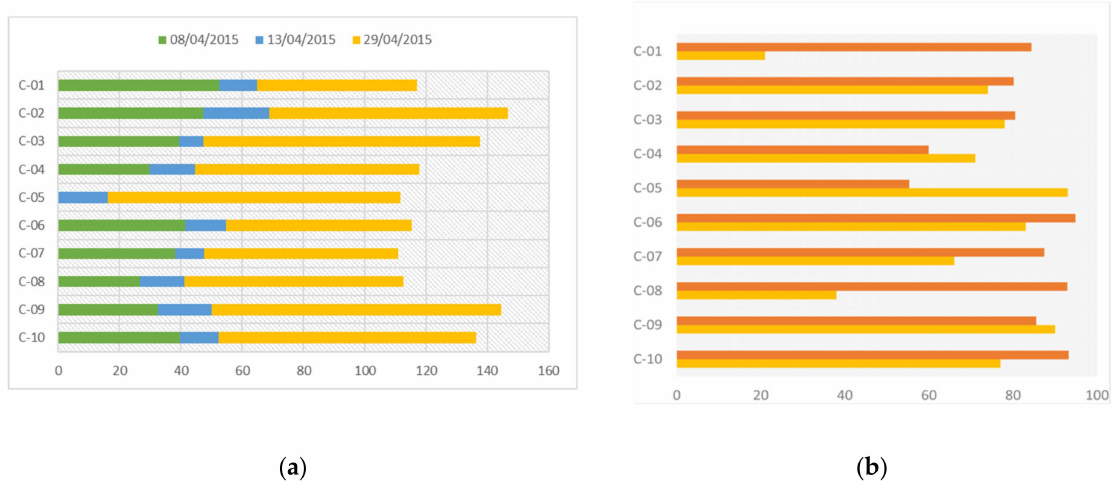
Figure 2. Melissopalynological analysis: ( a ) The % ( w / w ) Brassica t. loads in corbicular pollen at the beginning (8 April 2015), middle (13 April 2015), and end (29 April 2015) of winter oilseed rape (wOSR) flowering; ( b ) The frequency (%) of Brassica t. pollen in beebread and honey : C-01 to C-05 = Control hives; C-06 to C-10 = hives exposed to